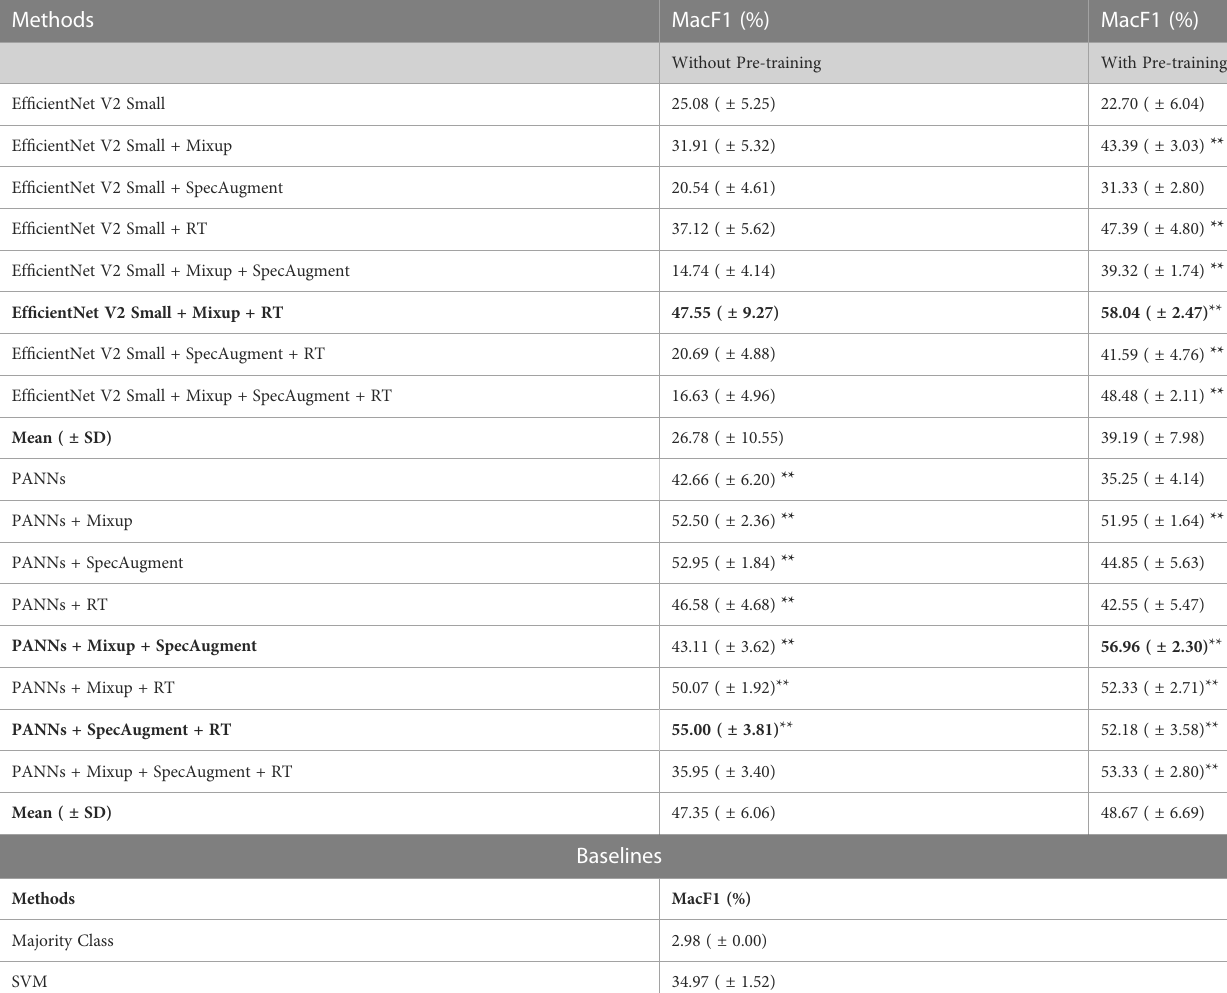
TABLE 4 Average predictive performance of Deep Learning models combined with an audio feature extraction technique (Log Mel-Spectrogram) to recognize bee species based on buzzing sounds recorded during visits to fl owers of blueberry cultivars in southern Chile.